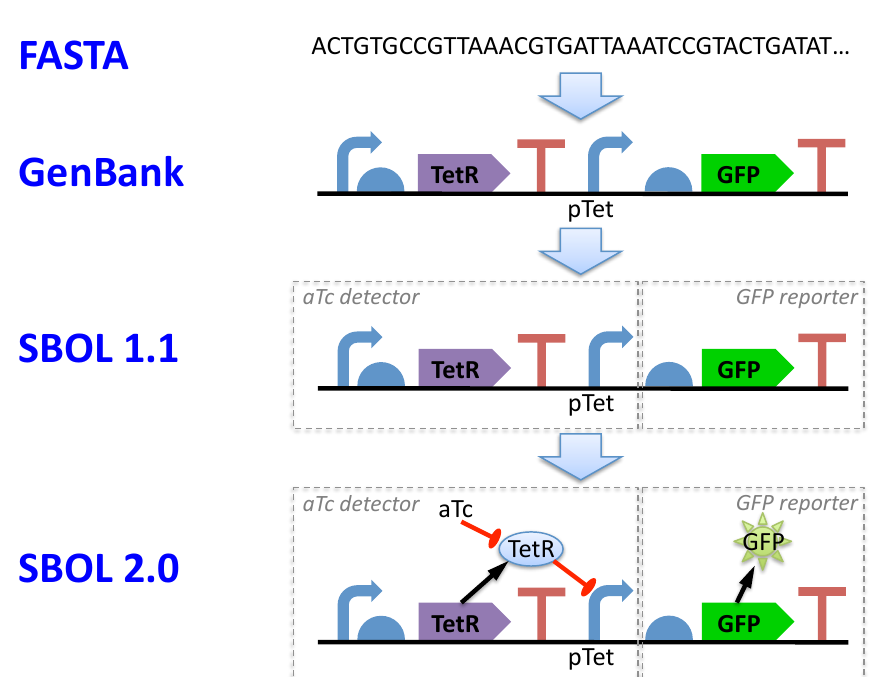
Figure 1: SBOL 2.0 extends prior sequence description formats to represent both the structure and function of a genetic design in a modular, hierarchical manner.